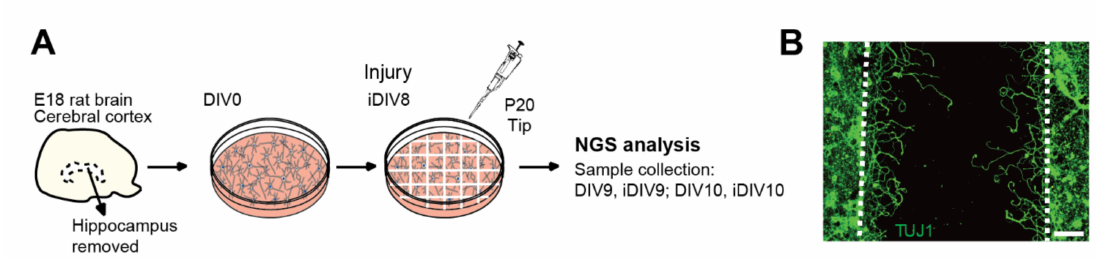
Figure 1. In vitro traumatic brain injury (TBI) model used in this study. ( A ) Schematic overview of the chromatin immunoprecipitation-sequencing (ChIP-seq) experimental design. Cerebral cortex was dissected from embryonic day 18 (E18) rat brain and the hippocampus was removed. Primary cortical neurons were dissociated, seeded on day in vitro (DIV) 0 and injured on DIV8 with a p20 tip to generate injury gaps. Control and injured cortical neurons were collected on DIV9 and DIV10 respectively for ChIP-seq, followed by bioinformatic analysis. NGS, next generation sequencing. ( B ) Injured neuronal culture was fixed with 4% paraformaldehyde on DIV11 and subjected to immunofluorescence staining with anti-TUJ1 (neuron-specific class III beta-tubulin) antibody. Dotted white lines depict the borders of the injury gap. Re-growing neurites are shown extending into the gap. Scale bar, 100 µ